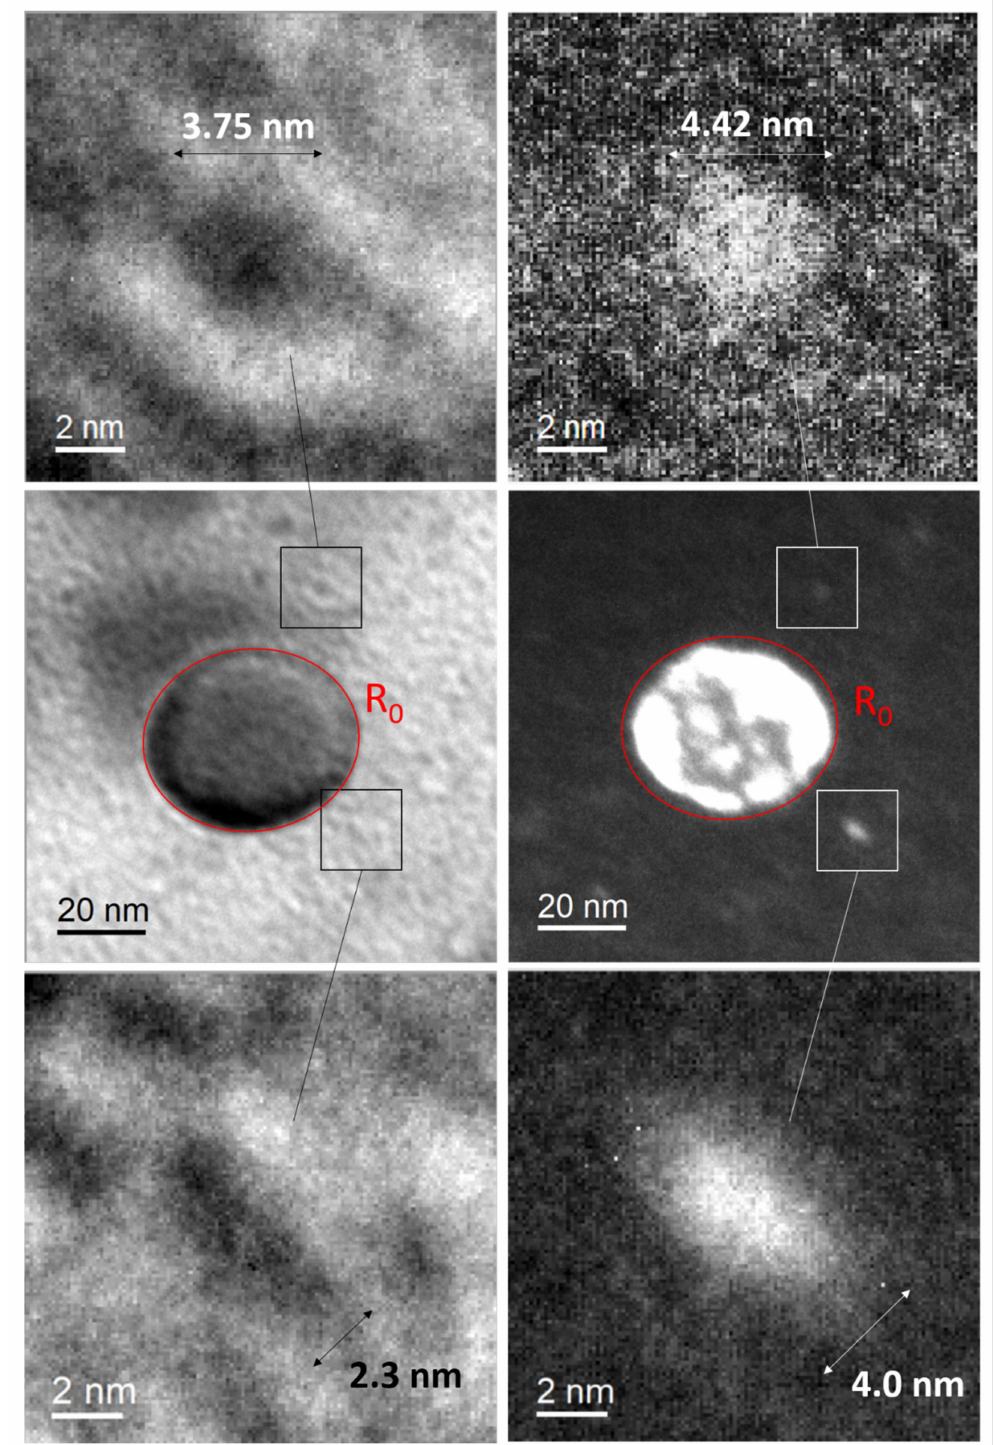
Figure 12. Radiation-induced inverse Ostwald ripening after 150 keV Fe + ion irradiation: ( a ) bright-field image of a large oxide surrounded by nano-oxides before irradiation, ( b ) dark-field image of the same particles after irradiation (4 dpa), ( c ) a neighbouring nano-oxide before irradiation, ( d ) the same neighbouring nano-oxide after irradiation (4 dpa), which appears larger, ( e ) another neighbouring nano-oxide before irradiation, ( f ) the same nano-oxide after irradiation (4 dpa), which appears